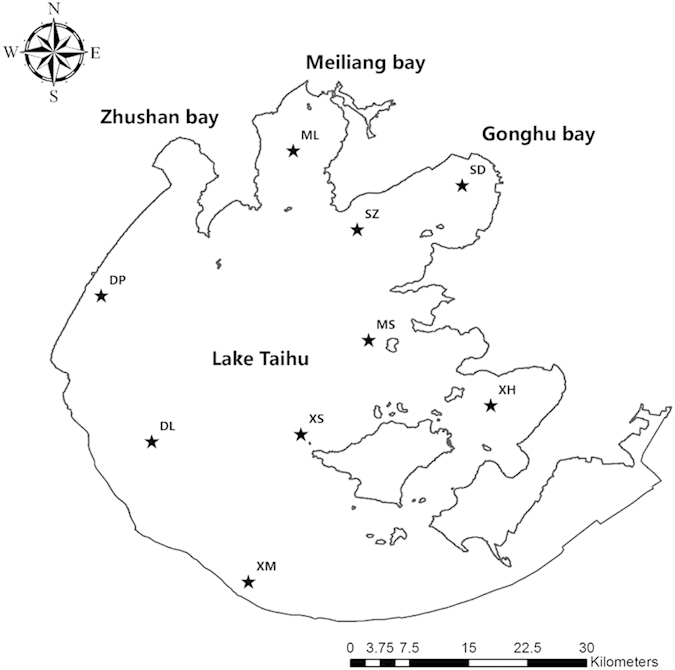
Geographic location of 9 different sample sites in Lake Taihu.Solid stars denote locations of the 9 national monitor stations where the samples were collected in this study.